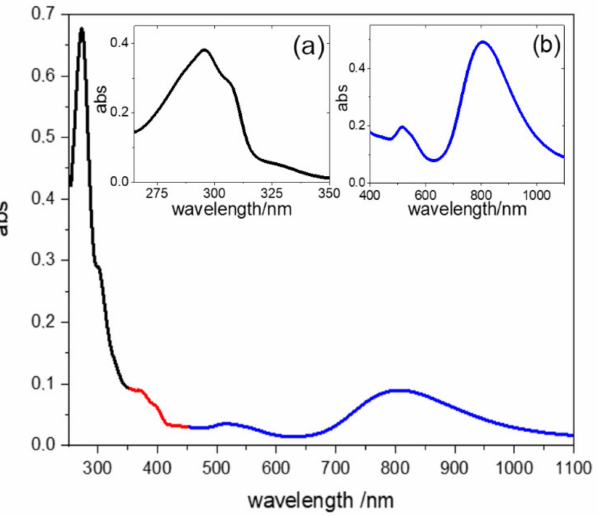
Figure 4. The absorption spectrum of Bpy-SH@AuNR in water solution. The three spectral zones are drawn in different colors: bands attributed to the isolated Bpy-SH transitions (black line), bands at- tributed to the aggregated Bpy-SH transitions (red line), bands due to the plasmonic resonances (blue line). Subfigure ( a ): absorption spectrum of diluted Bpy, see Figure S5 in Supplementary Materials; Subfigure ( b ): extinction spectrum of Bpy-SH@AuNR. The absorption spectrum of the concentrated solution was not collected due to the high concentration.